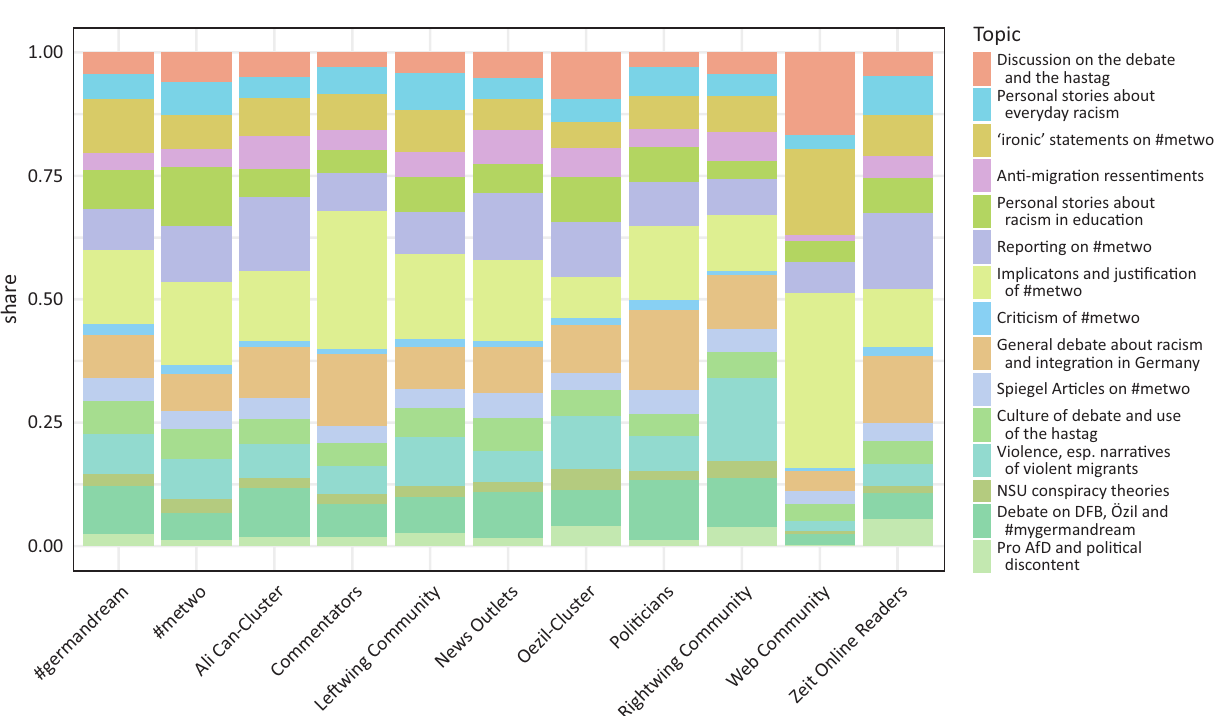
Figure 4. Topics found under the hashtag #metwo and their relative share of tweets within